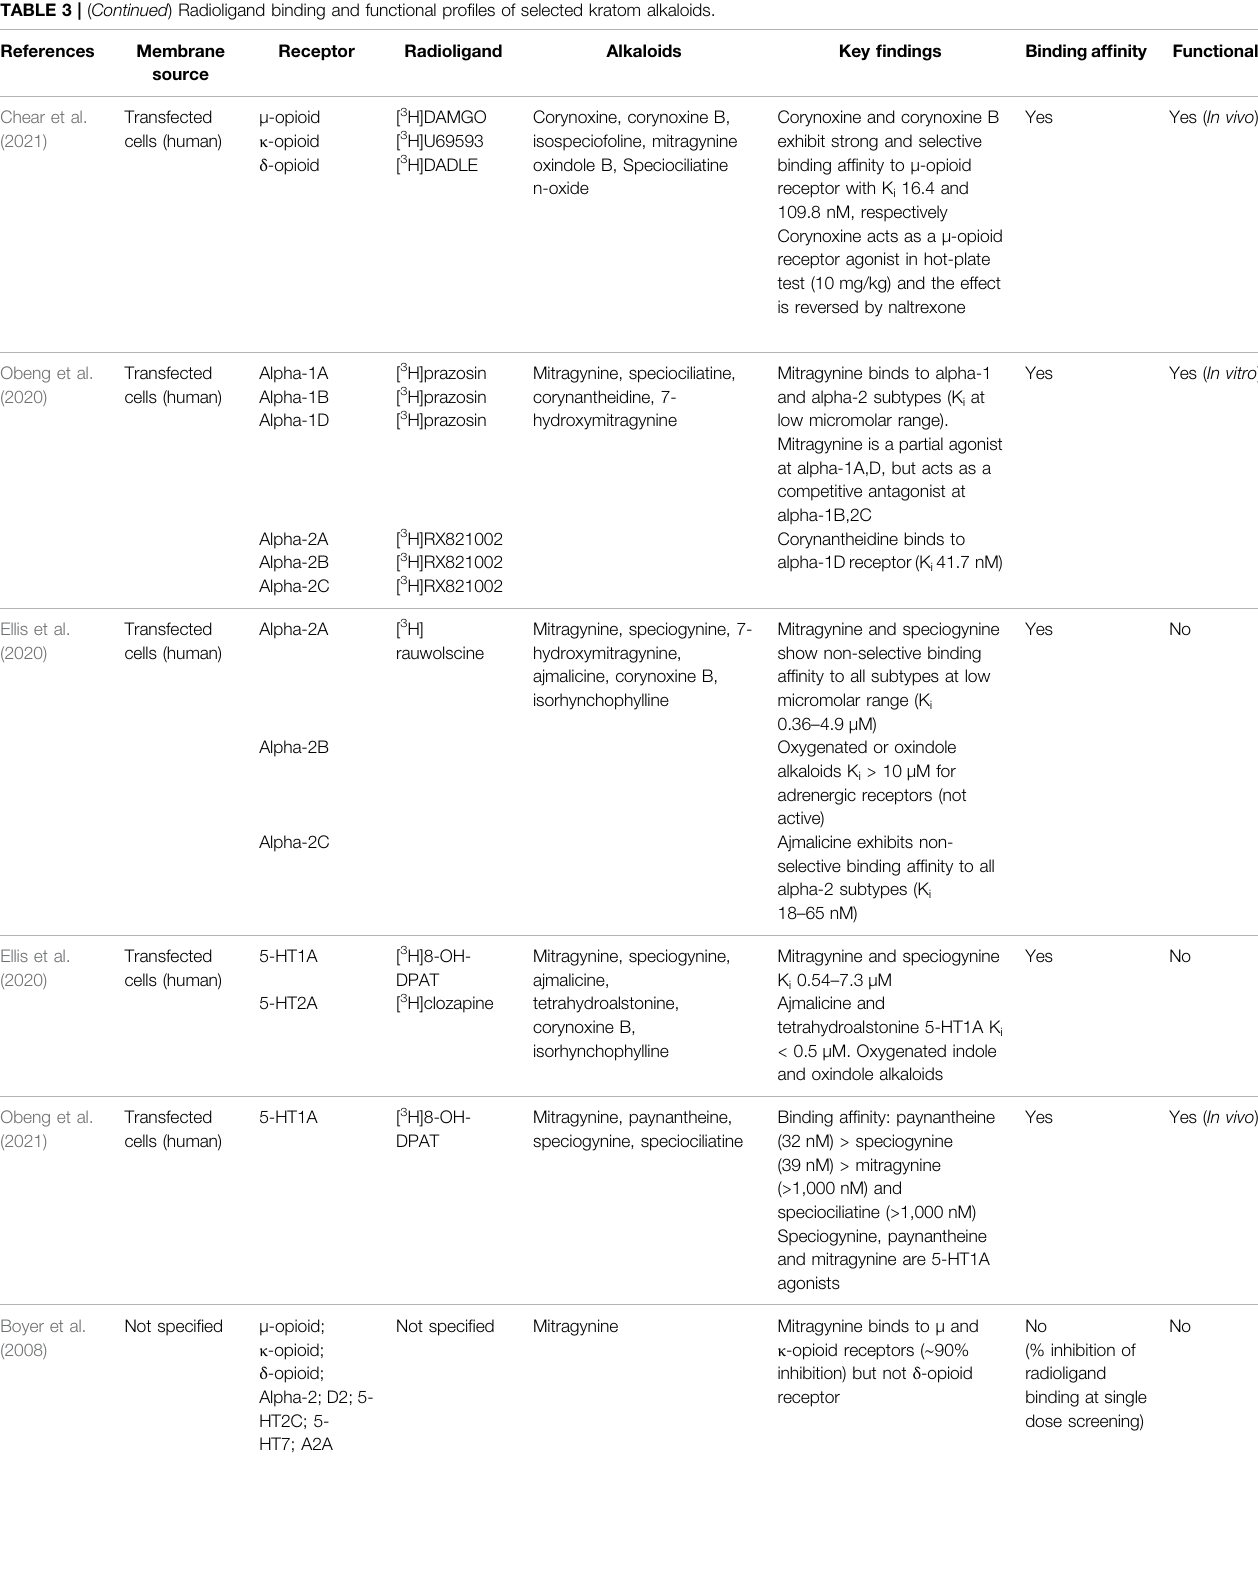
TABLE 3 | ( Continued ) Radioligand binding and functional pro fi les of selected kratom